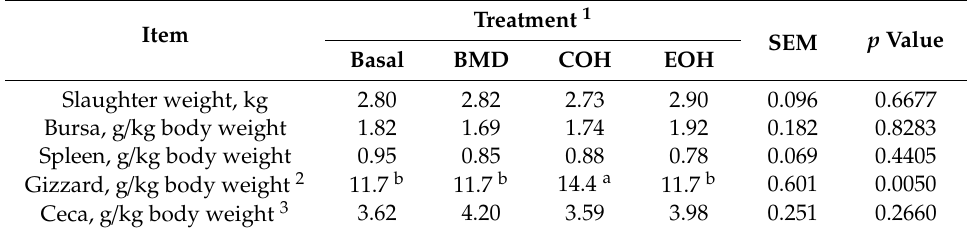
Table 4. E ff ect of dietary supplementation with coarse or extruded oat hulls on organ weights of broiler chickens.